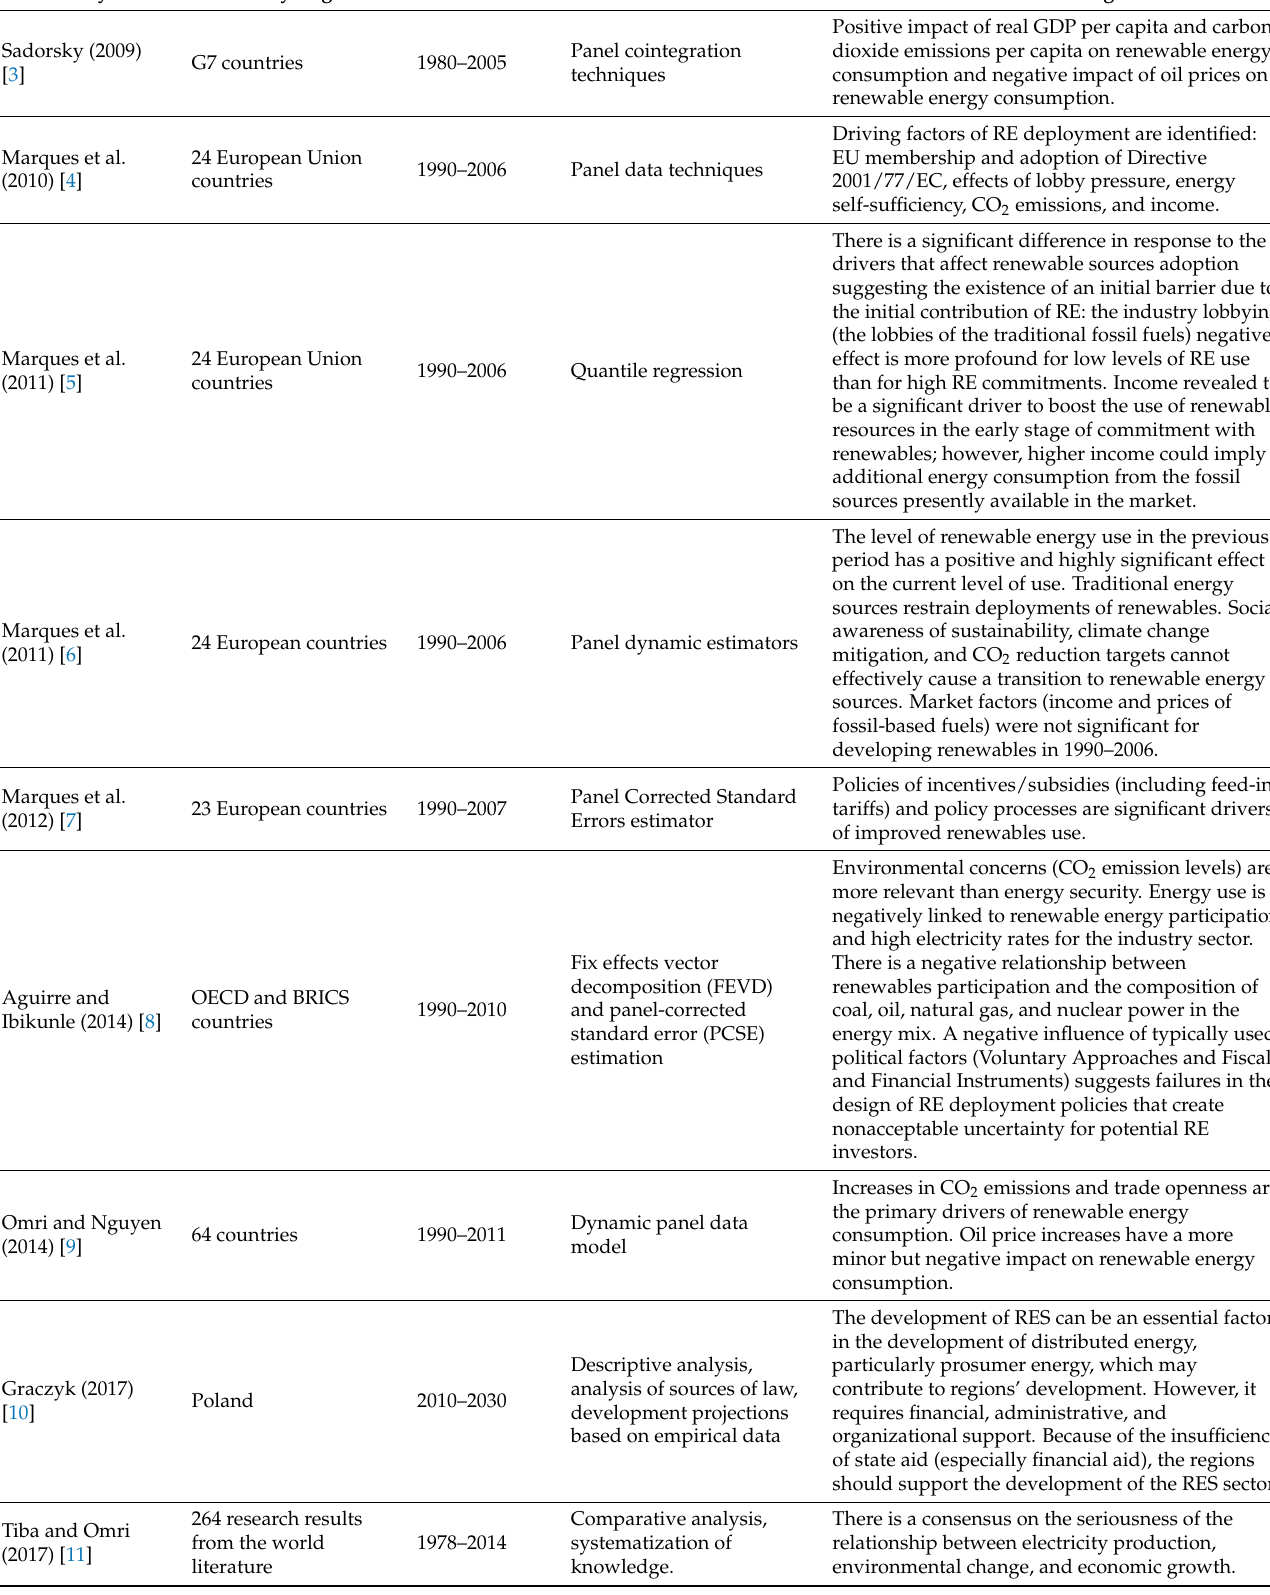
Table 1. The summary of the literature